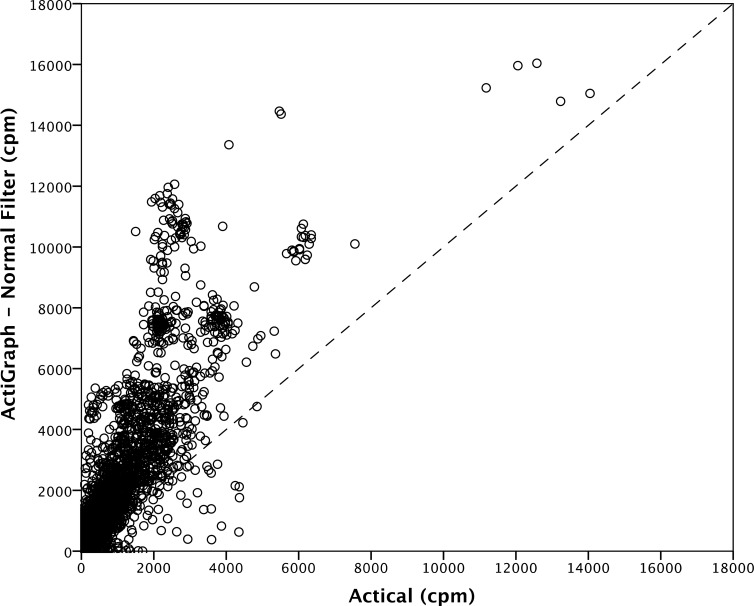
Scatterplot depicting the relationship between ActiGraph (normal filter) and Actical counts per minute (CPM) (r = 0.815).